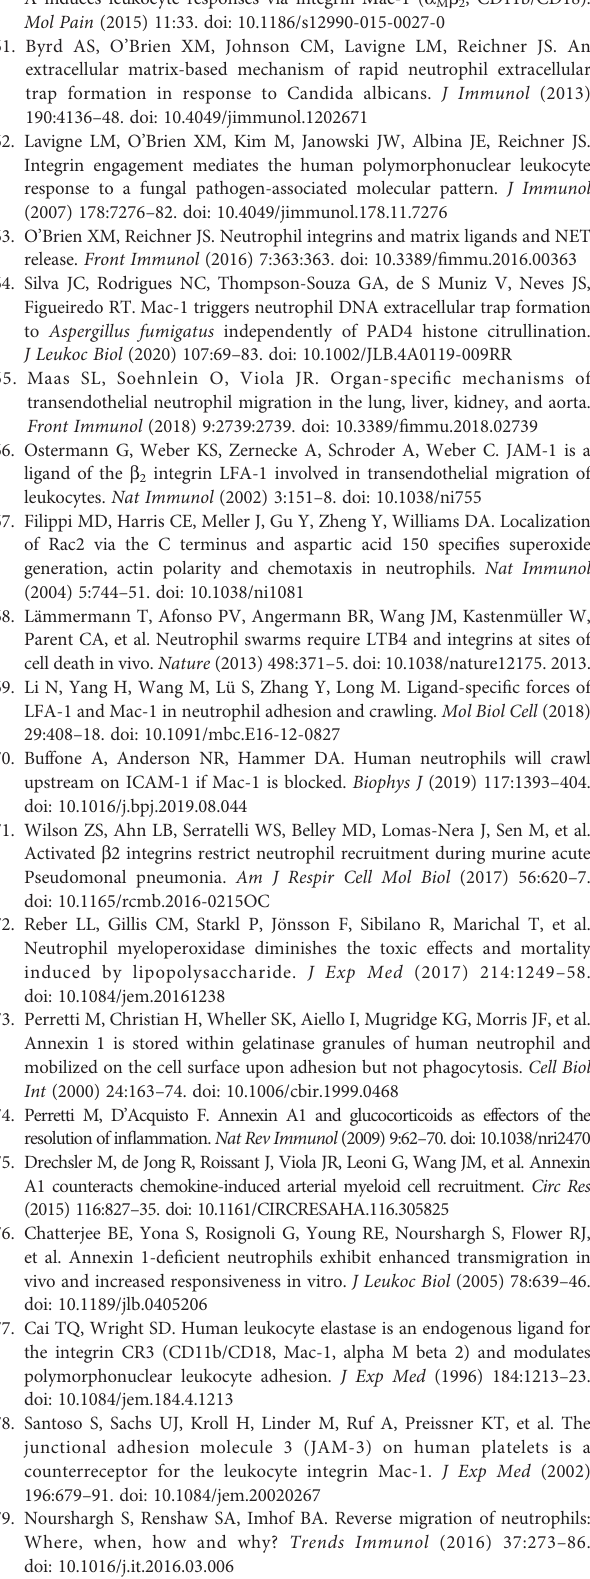
Figueiredo RT. Mac-1 triggers neutrophil DNA extracellular trap formation to Aspergillus fumigatus independently of PAD4 histone